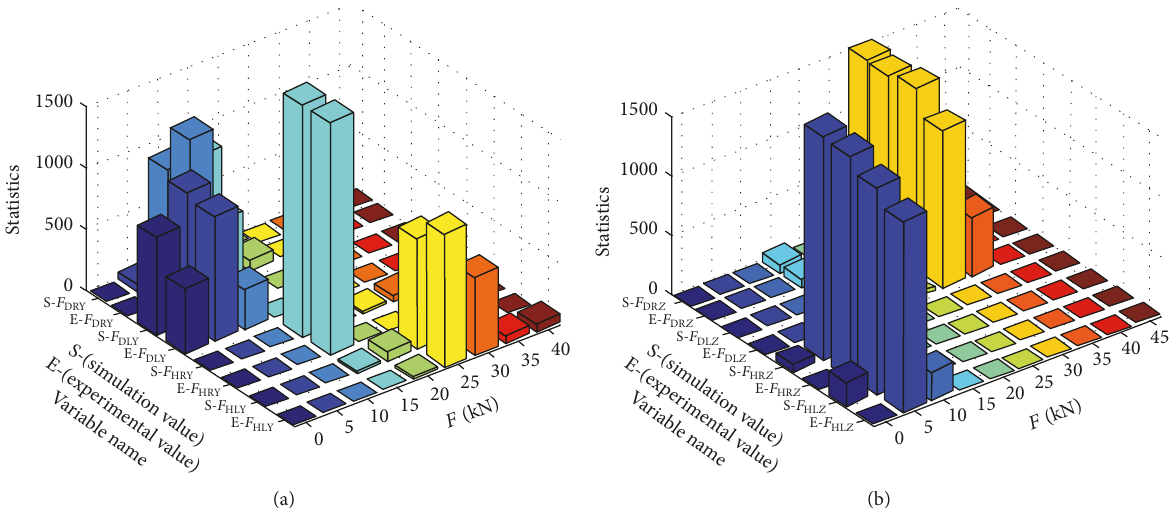
Figure 8: Comparison between simulation and experimentally obtained cumulative load frequencies along 𝑌 and 𝑍 directions. (a) Cumulative load frequency along 𝑌 direction and (b) cumulative load frequency along 𝑌 direction.